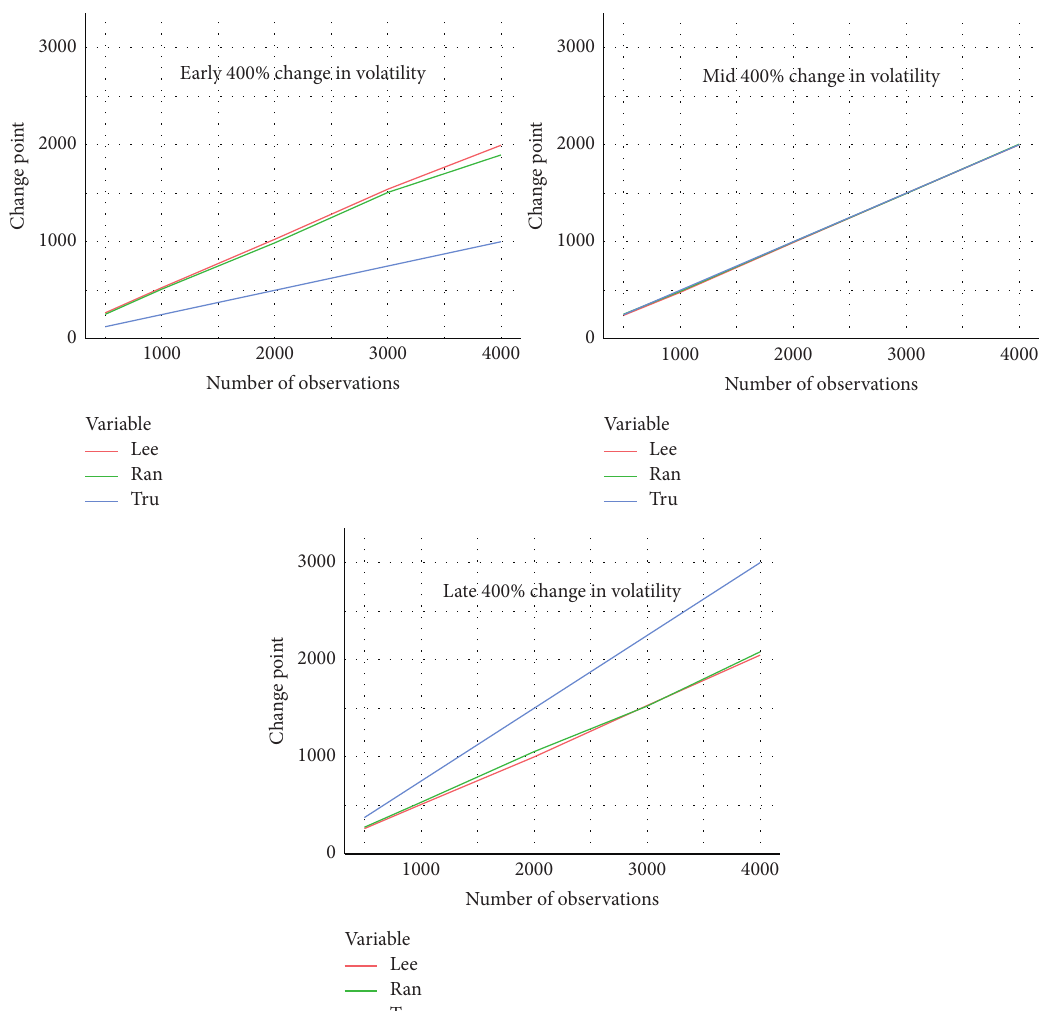
Figure 2: Graph showing an early, middle, and late change with a 400% change in volatility of the True(Tru), ordinary CUSUM(Lee) of [20], and Randomised(Ran)